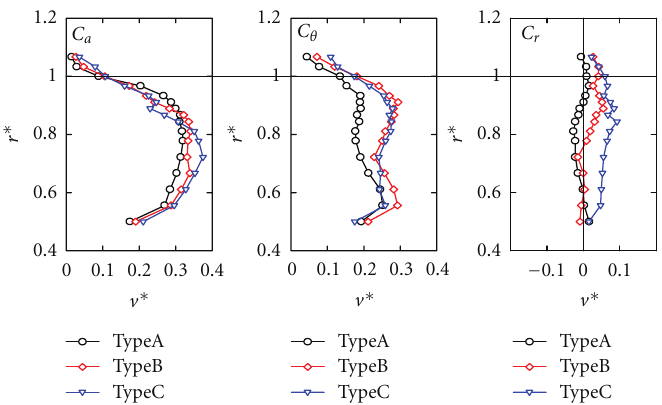
Figure 7: Comparison of the e ff ect of inlet geometry on time-mean velocity distributions at φ = 0 . 290.